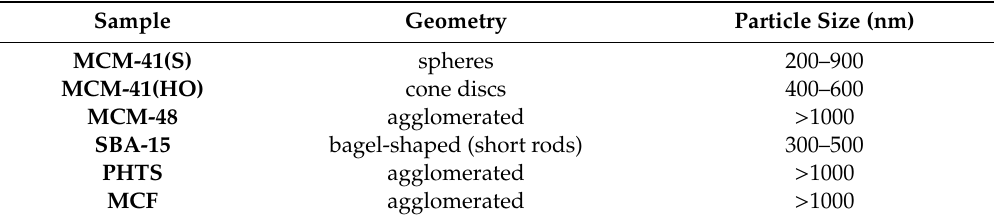
Table 2. The range of particle size and geometry of the particles obtained via